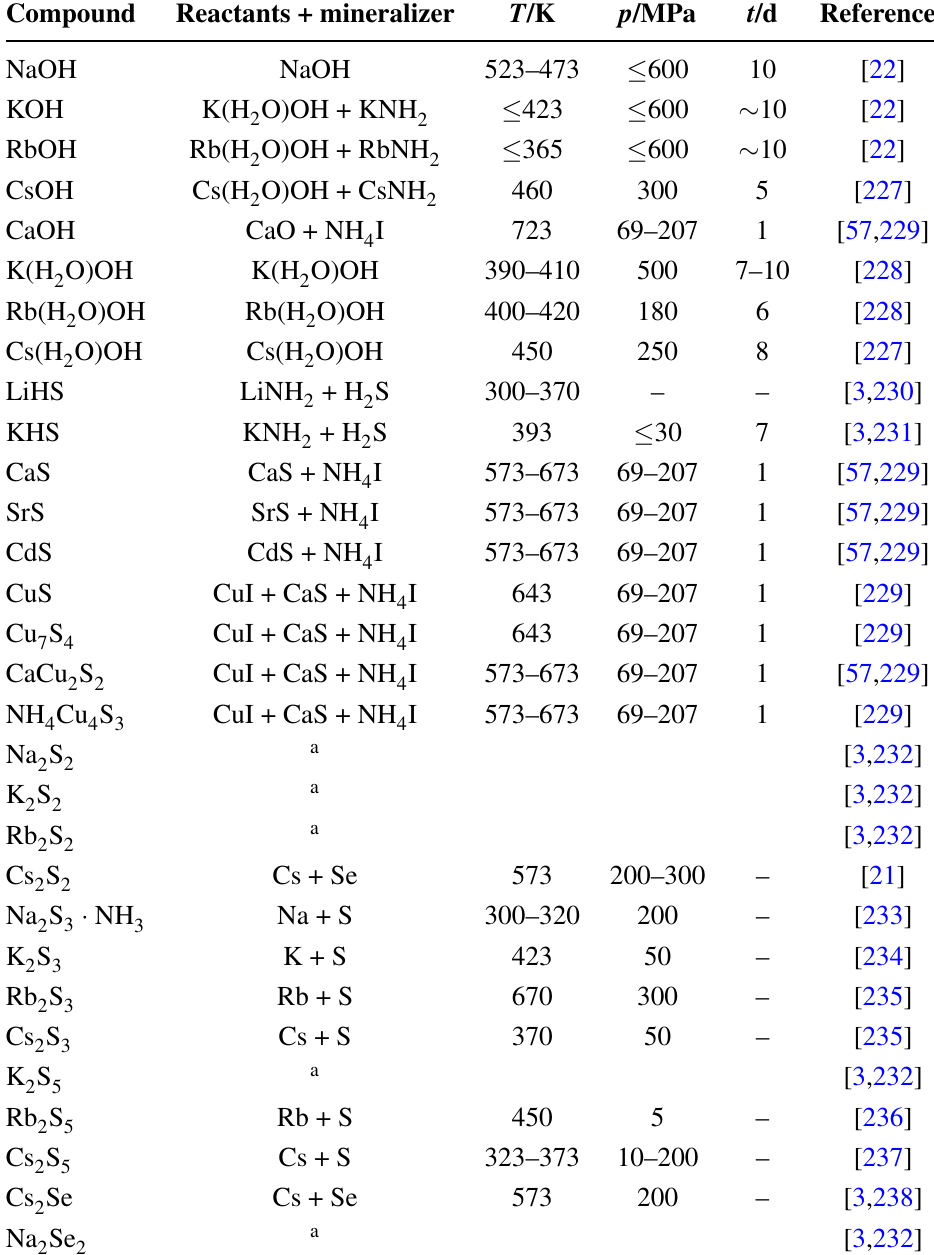
Table 11. Conditions for the ammonothermal synthesis of non-nitrogen compound